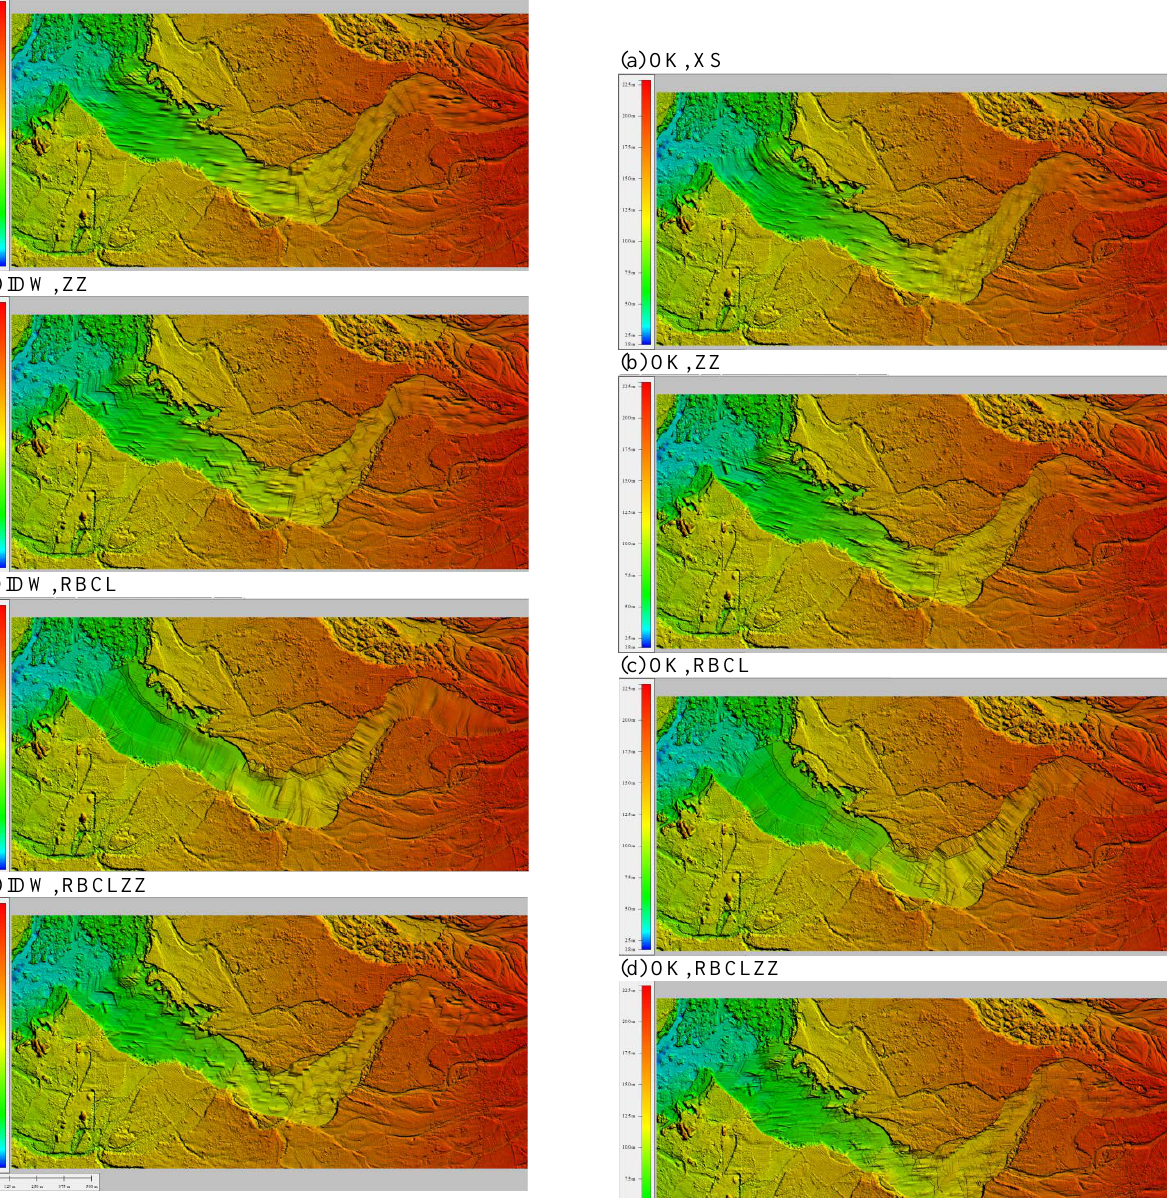
Figure 4. Results of Inverse Distance Weighted (IDW) interpolation.